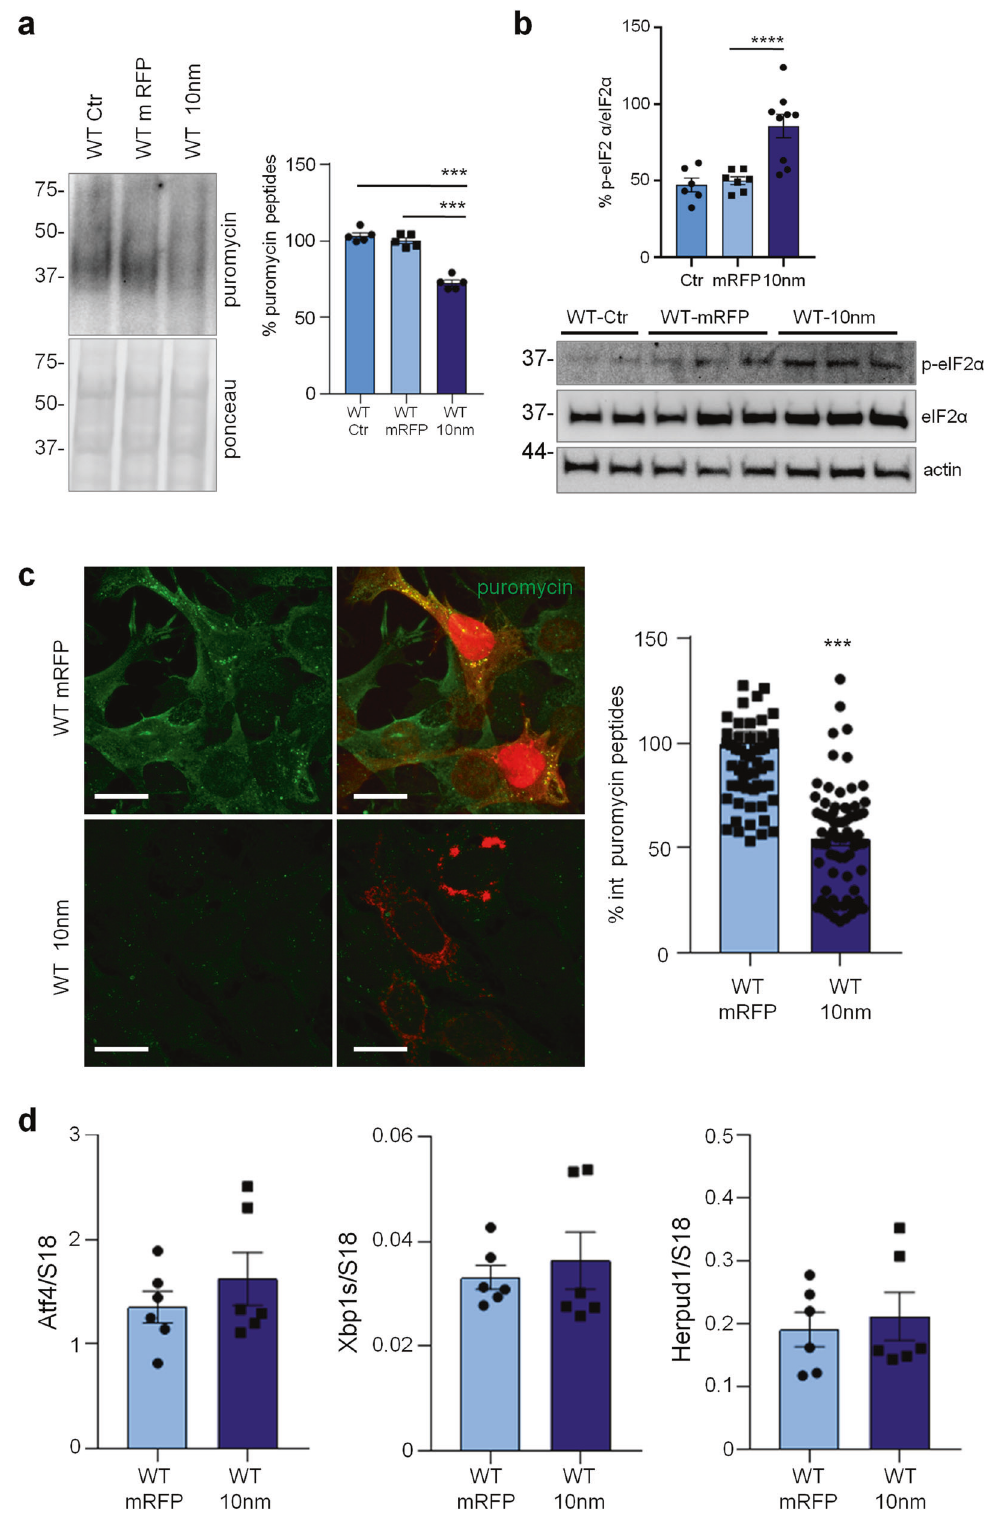
Fig. 4 Forced ER-mitochondria interaction causes impairment of protein synthesis in WT-iAstro cells. WT-iAstro cells were non-transfected (WT Ctr) or transfected with mRFP (WT mRFP) and 10-nm ER- mitochondrial linker (WT 10nm). a WB with anti-puromycin antibody and ponceau staining on lysates of cells treated with 4 µM puromycin (1.5 h); data are expressed as mean ± SEM of three independent experiments; *** p < 0.001 by one- way ANOVA, Sidak ’ s multiple comparison. b WB analysis of eIF2 α phosphorylation. Data are expressed as mean ± SEM of four independent experiments; **** p < 0.0001 by one- way ANOVA, Sidak ’ s multiple comparison. c Cells pulsed with 4 µM puromycin (1.5 h) were fi xed and analysed by IF with anti-puromycin antibody (green). Images were acquired with Zeiss 710 confocal laser scanning microscope, data are expressed as mean ± SEM of three independent coverslip; *** p < 0.001 by unpaired t -test. Scale bar = 25 μ m. d Real-time PCR of Atf4, Xbp1s and Herpud1 transcripts in cells transfected with mRFP and 10-nm ER-mitochondrial linker; data are expressed as mean ± SEM of four independent wells. Cell Death and Disease (2022)